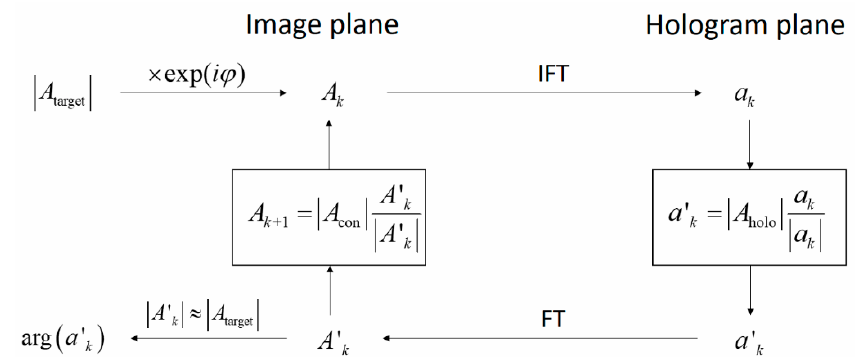
Figure 3. The block diagram of WCIA.